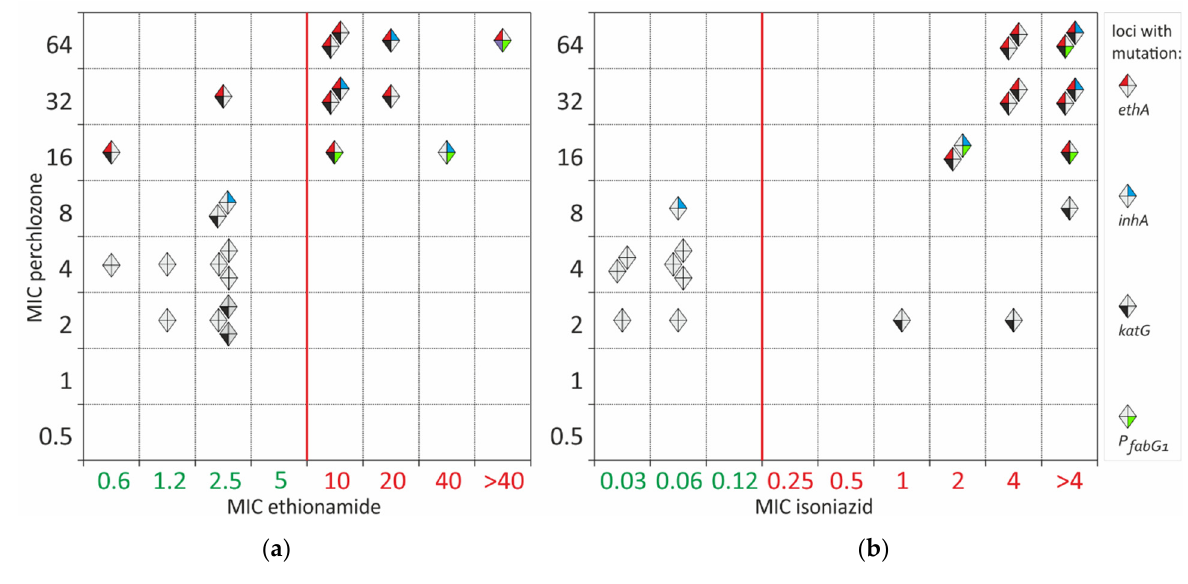
Figure 2. Pairwise MIC correlation of perchlozone with ethionamide ( a ) and perchlozone with isoniazid ( b ). Each isolate is shown with a diamond. Isolates with wild-type sequences are grey. Isolates with mutations are color-labelled, as indicated in the legend: mutations in ethA are labelled with red color of the left-top sector. Isolates with mutations in inhA are labelled with a blue color of the top-right sector. Isolates with mutations in katG are marked with black and those with mutations in the fabG1 promoter have a green label in the bottom left and bottom right sectors, respectively.